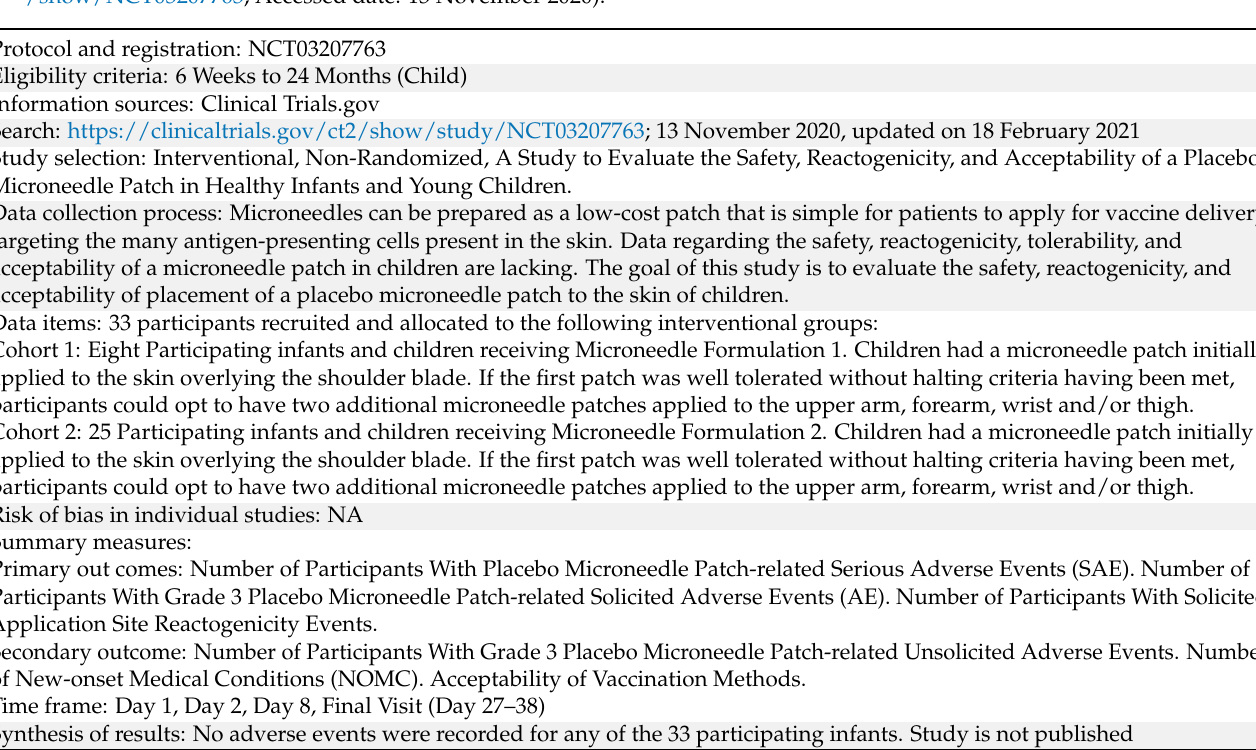
Table A3. Second study: Microneedle Patch Study in Healthy Infants/Young Children. (https://clinicaltrials.gov/ct2 /show/NCT03207763; Accessed date: 13 November